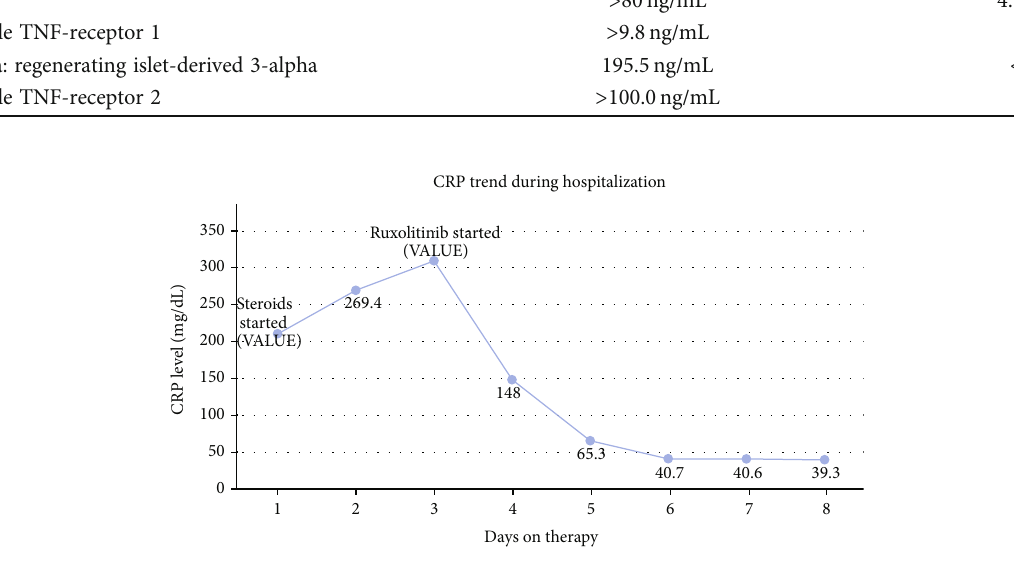
Figure 6: C-reactive protein trend during hospitalization for case